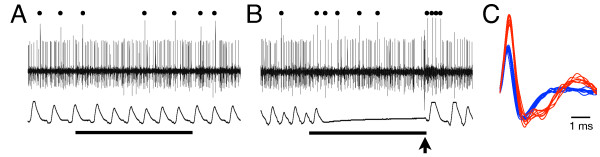
Simultaneous recordings of PC activities and heartbeats during the conditioning procedure.A. The eighth trial in the habituation session. B. The 21st trial in the acquisition session. In this case, firing frequency of simple spikes was decreased during the first two seconds of the CS presentation in the 21st trial in the acquisition session (B). PC activities and heartbeats are shown in upper traces and lower traces, respectively. Dots indicate complex spikes. Horizontal bars indicate 5.1 s periods of CS presentations. The arrow indicates the timing of the US presentation. C. Superimposed recordings of simple (blue) and complex (red) spikes that were observed in A.